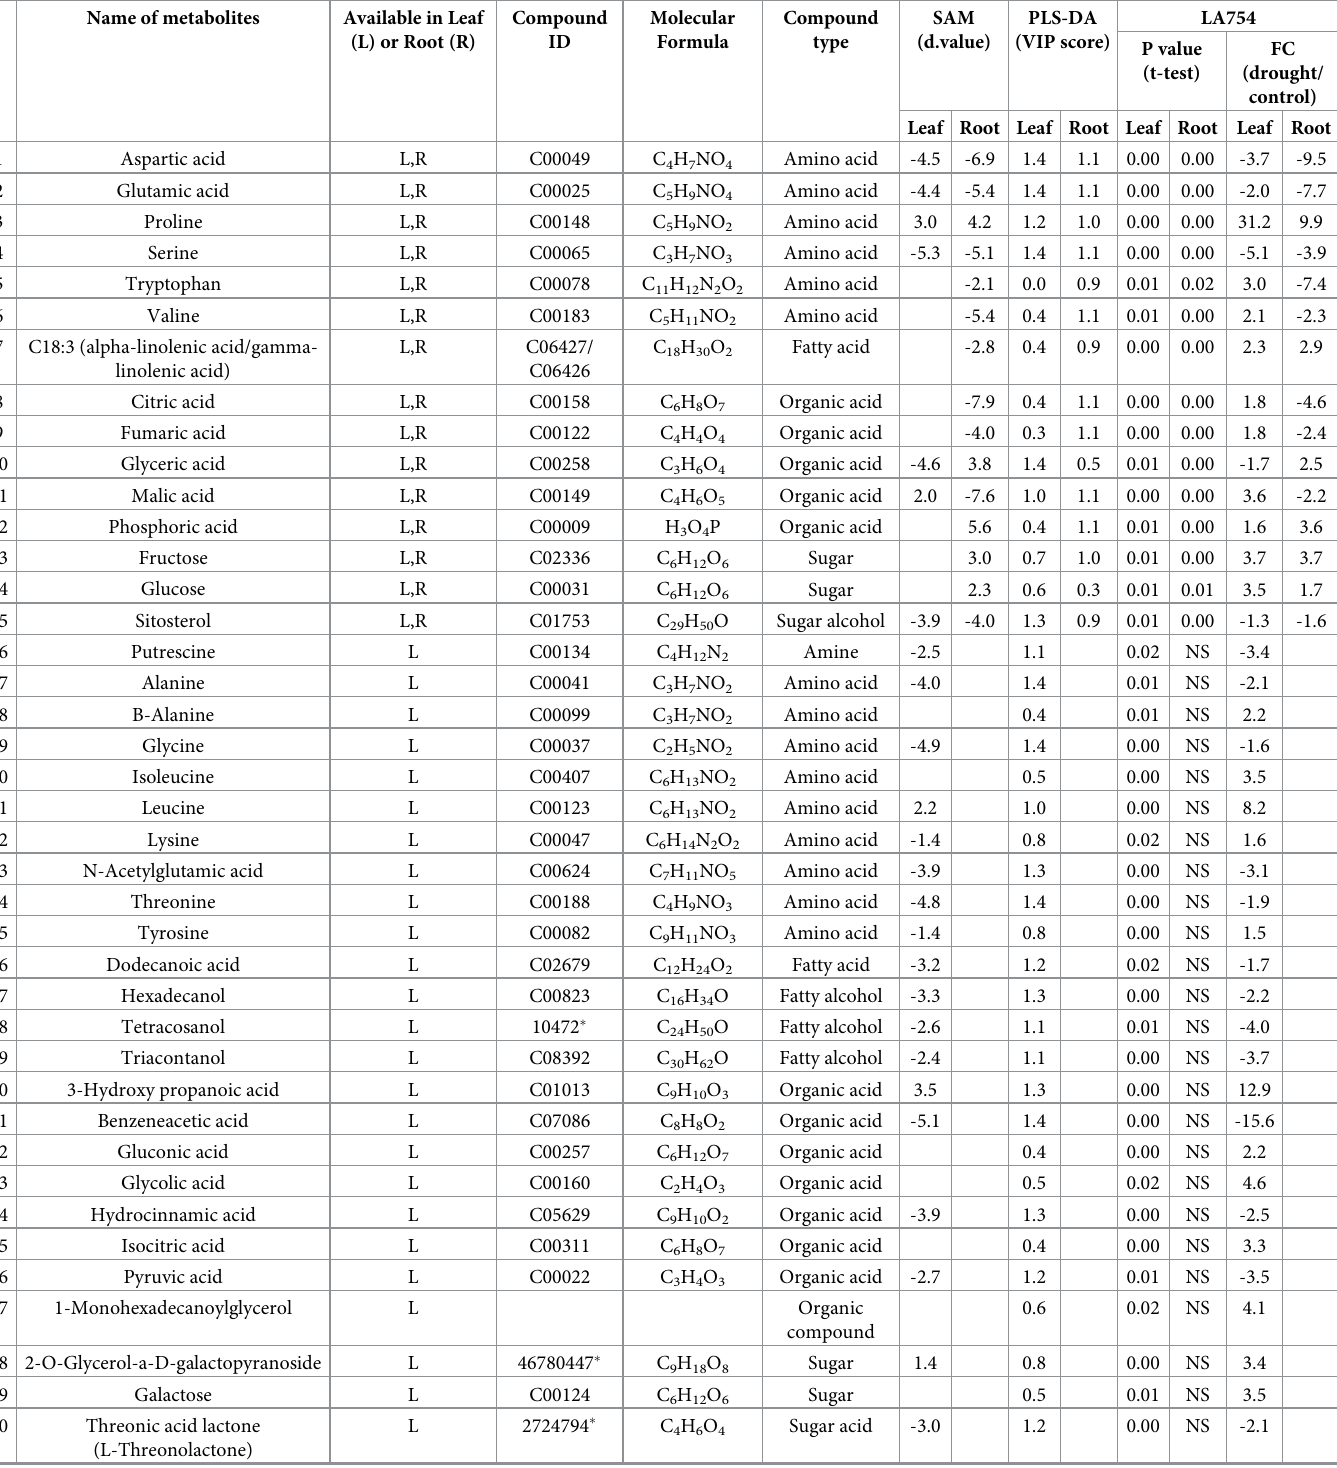
Table 3. List of 50 important metabolites with their Kyoto Encyclopedia of Genes and Genomes identifier number identifier number (KEGG ID/PubChem CID � ), molecular formula (MF), identified through Significant Analysis of Metabolites (SAM) and Partial Least Square Discrepant Analysis (PLS-DA) in LA754. T-test (P � 0.05) with their p-value and fold change (FC, drought/control) in the wheat flag leaves at 14 and 21days and roots at under drought and control